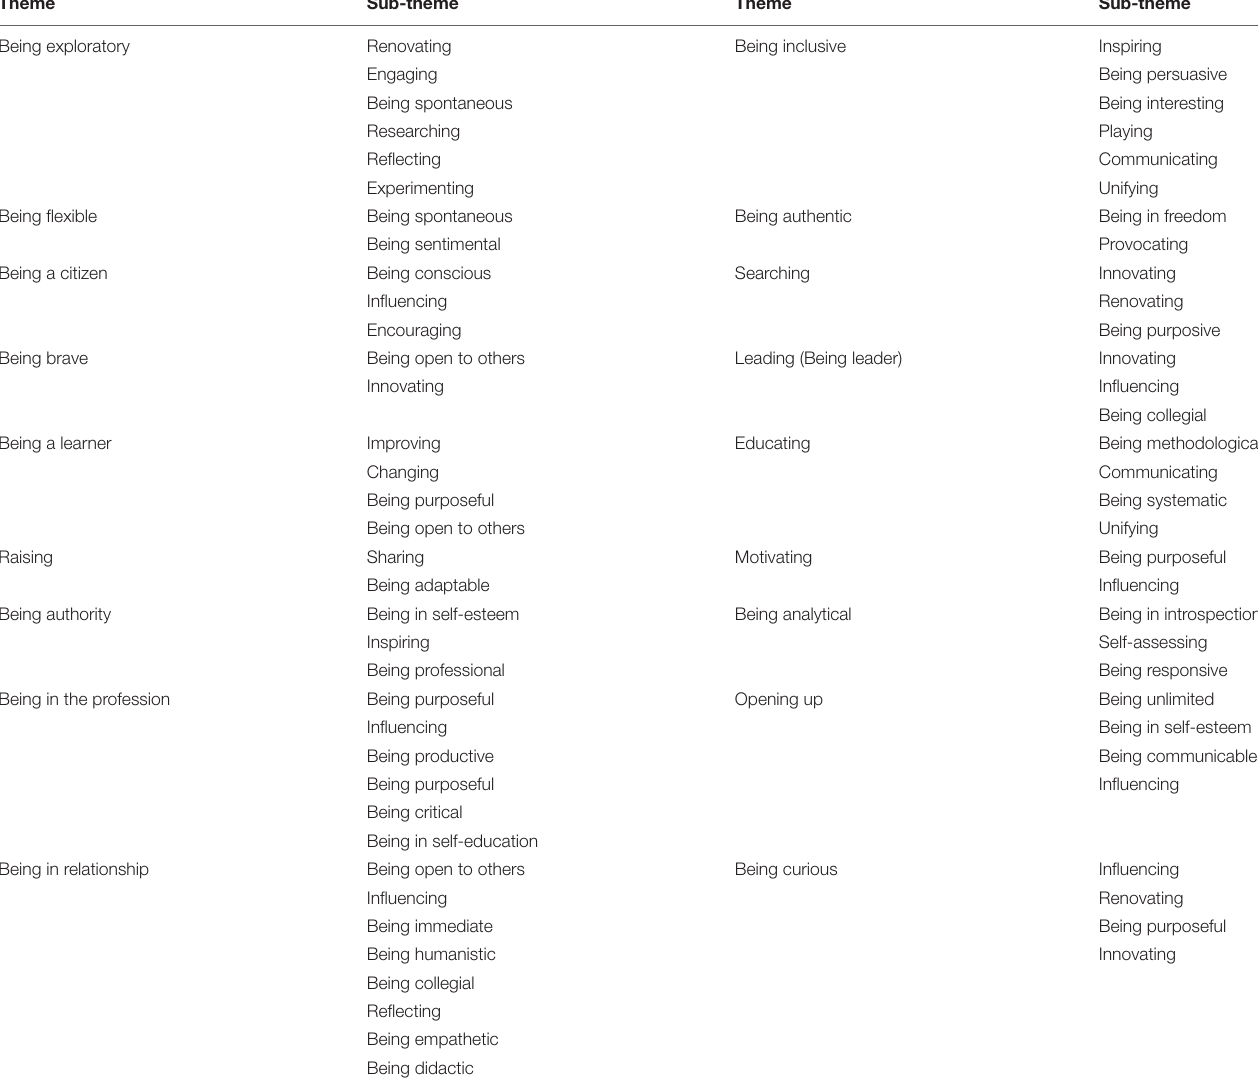
TABLE 1 | Leadership within the phenomenological structure of teacher